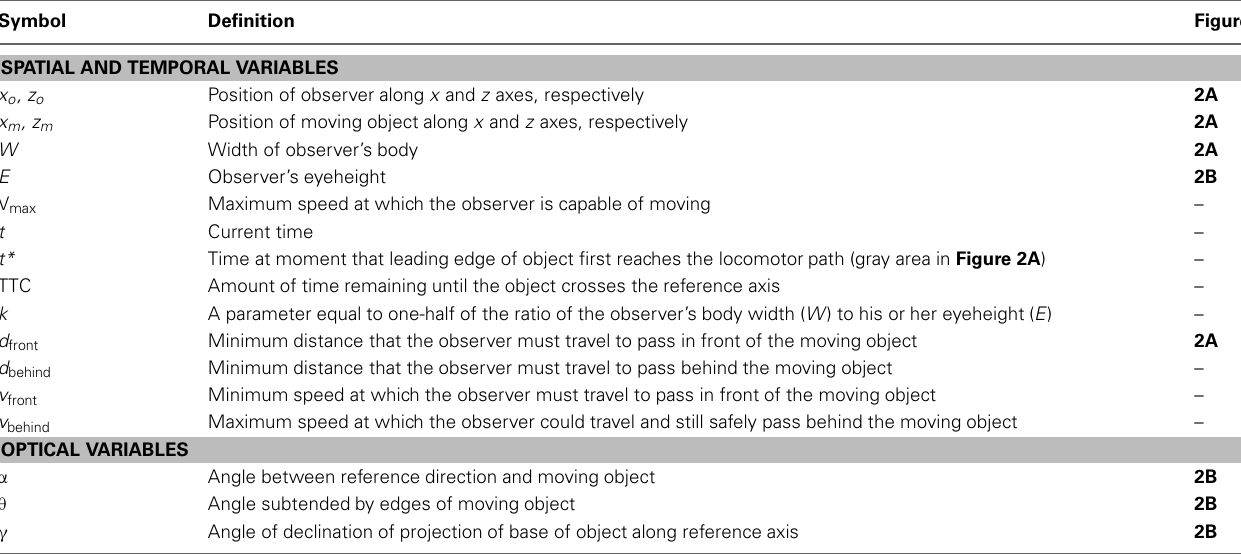
Table 1 | Definitions of symbols used to designate spatial, temporal, and optical